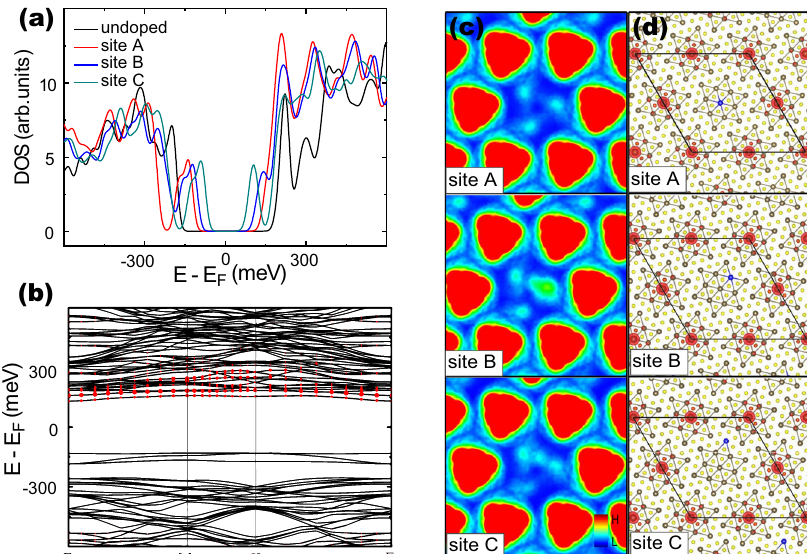
Fig. 2 First-principles DFT calculation of Ti-doped SD. a dI / dV spectrum, b band structure, c charge density, and d spin density for a 4-SD supercell. The three inequivalent substitution sites are marked by the blue atoms in d . b The band structure for the case where the central Ta is substituted by Ti. Red contours in c and d represent high charge and spin densities,